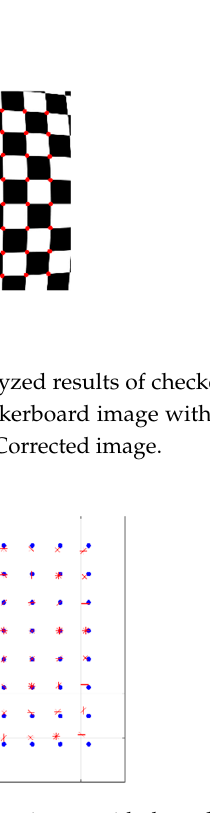
. Figure 10. Distorted fringe-patterns of size 2048 × 2448 pixels. The longitudinal fringe-patterns with a phase shift of 0, /2, ,3 /2 π π π are in the first row and the transverse with a phase shift of 0, /2, ,3 /2 π π π are in the second row.